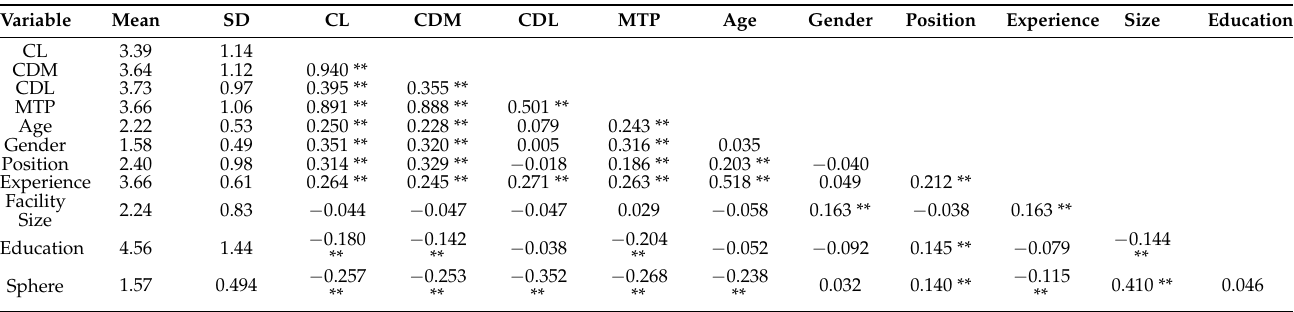
Table 3. Correlation matrix. Source: authors’